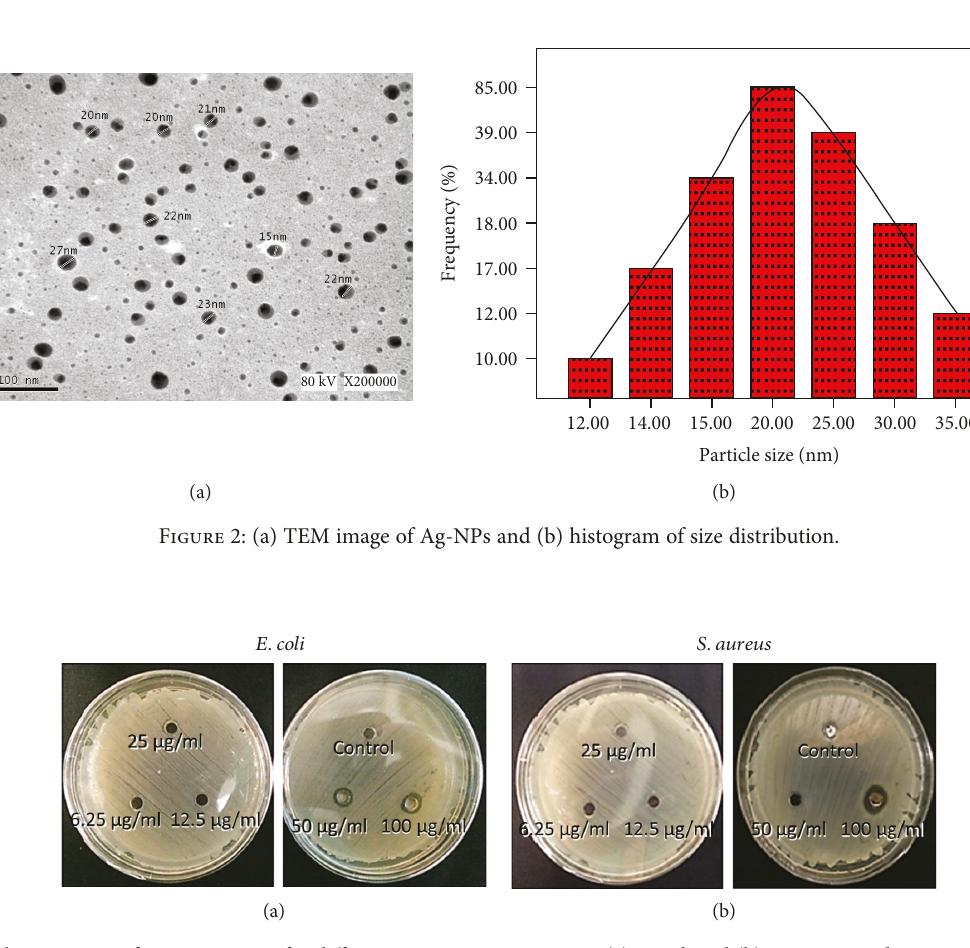
Figure 3: Inhibition zones of 20 nm Ag-NPs for di ff erent concentrations against (a) E. coli and (b) S. aureus under normal light condition .